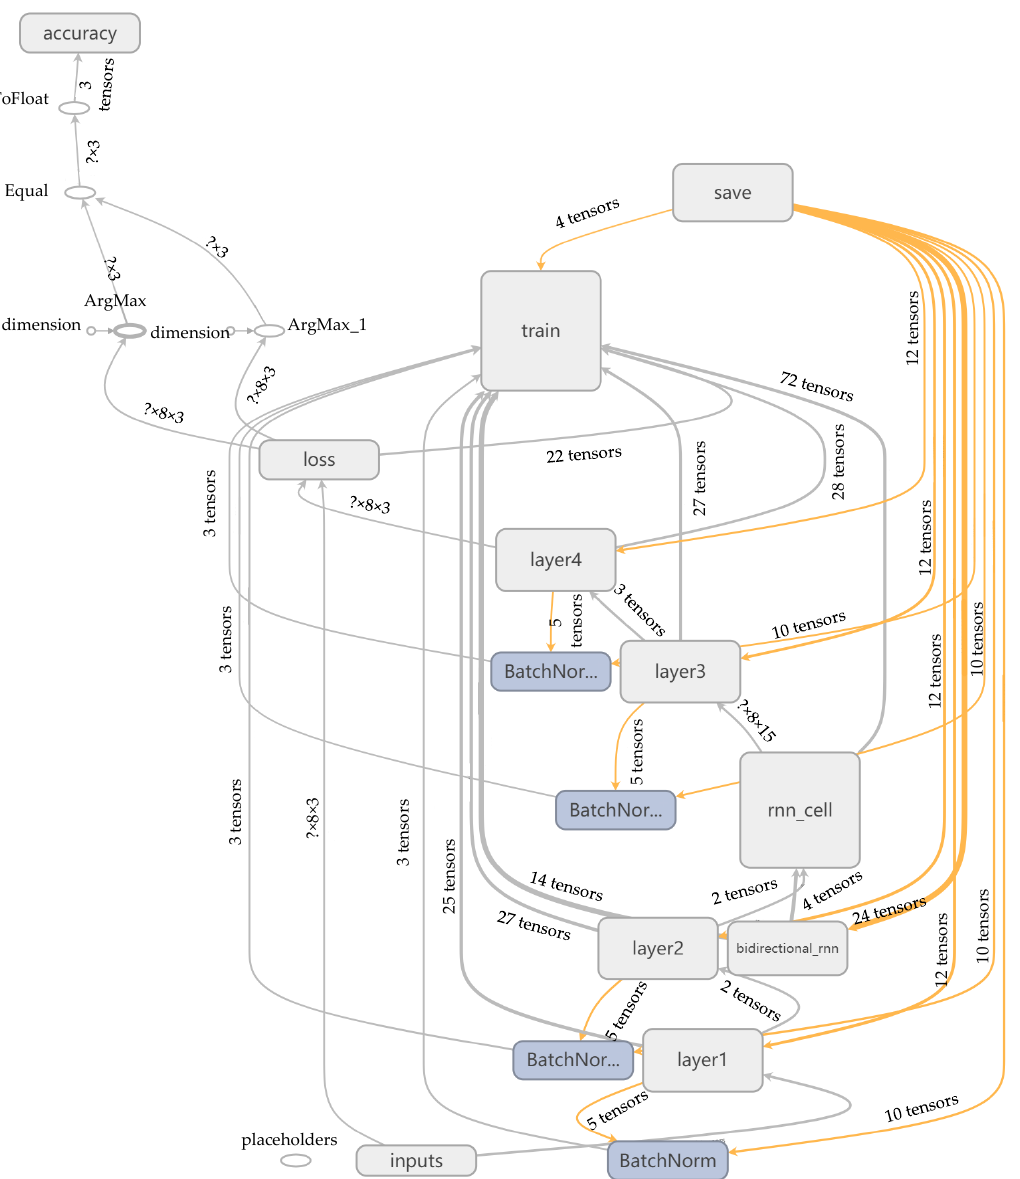
Figure 10. BI-LSTM-RNN structure diagram.